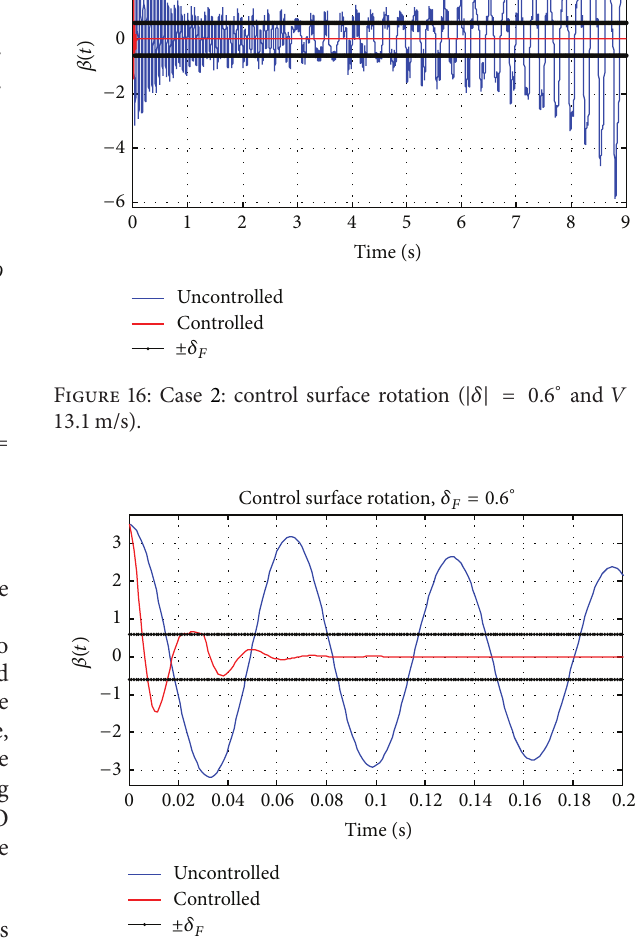
Figure 17: Case 2: zoom selection area for the control surface rotation ( |𝛿| = 0.6 ∘ and 𝑉 = 13.1